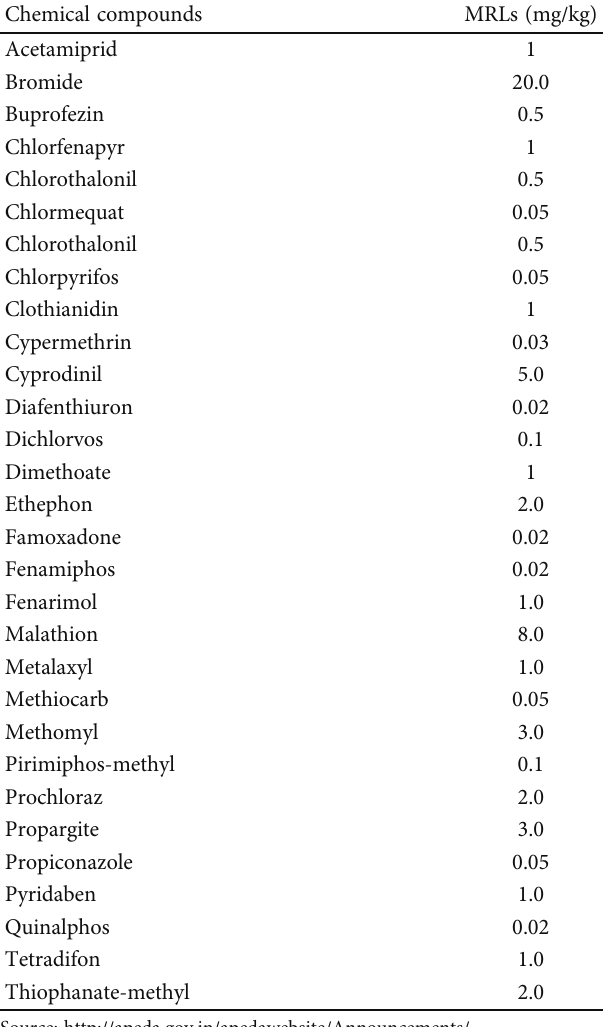
Table 4: Pesticide residues and their maximum residue limits